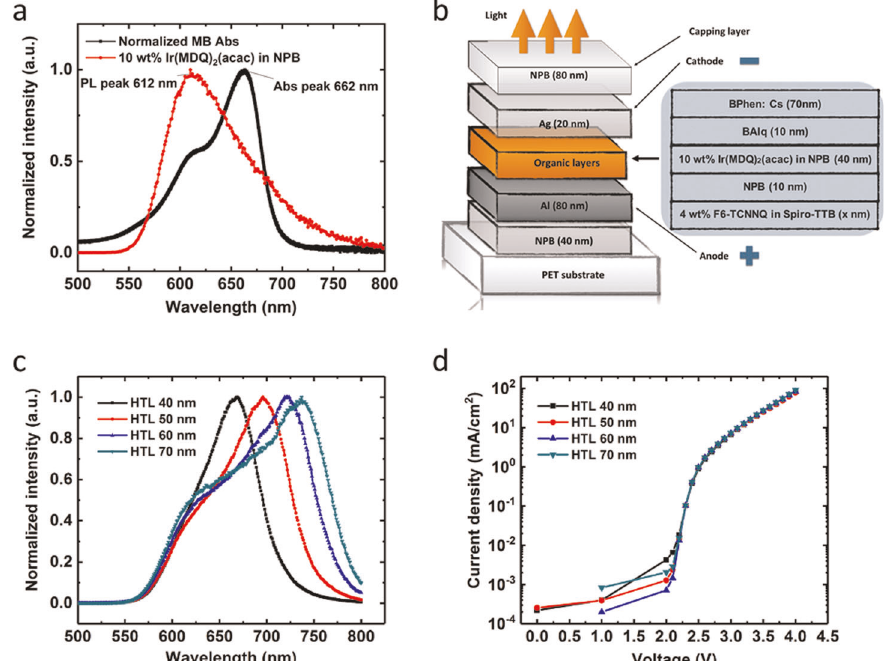
Fig. 1 Design of 16-mm 2 fl exible OLEDs. a Photoluminescence spectrum of Ir(MDQ) 2 (acac) and absorption spectrum of methylene blue. b Device structure of fl exible p – i – n OLED. c Electroluminescence spectra of OLEDs with 40, 50, 60 and 70-nm HTL thicknesses. d J – V characteristics of OLEDs with 40, 50, 60 and 70-nm HTL